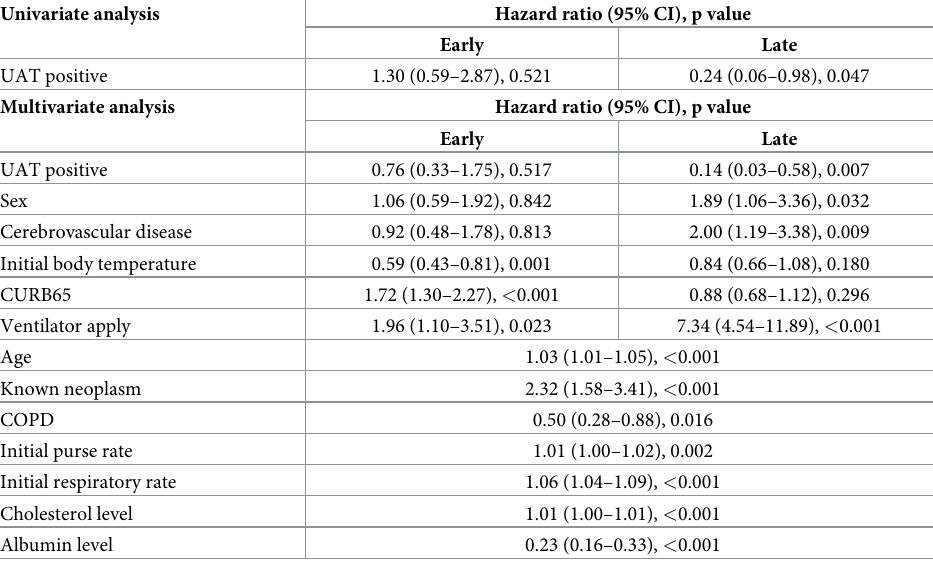
Table 3. Univariable and multivariable extended Cox-regression analyses. Univariate